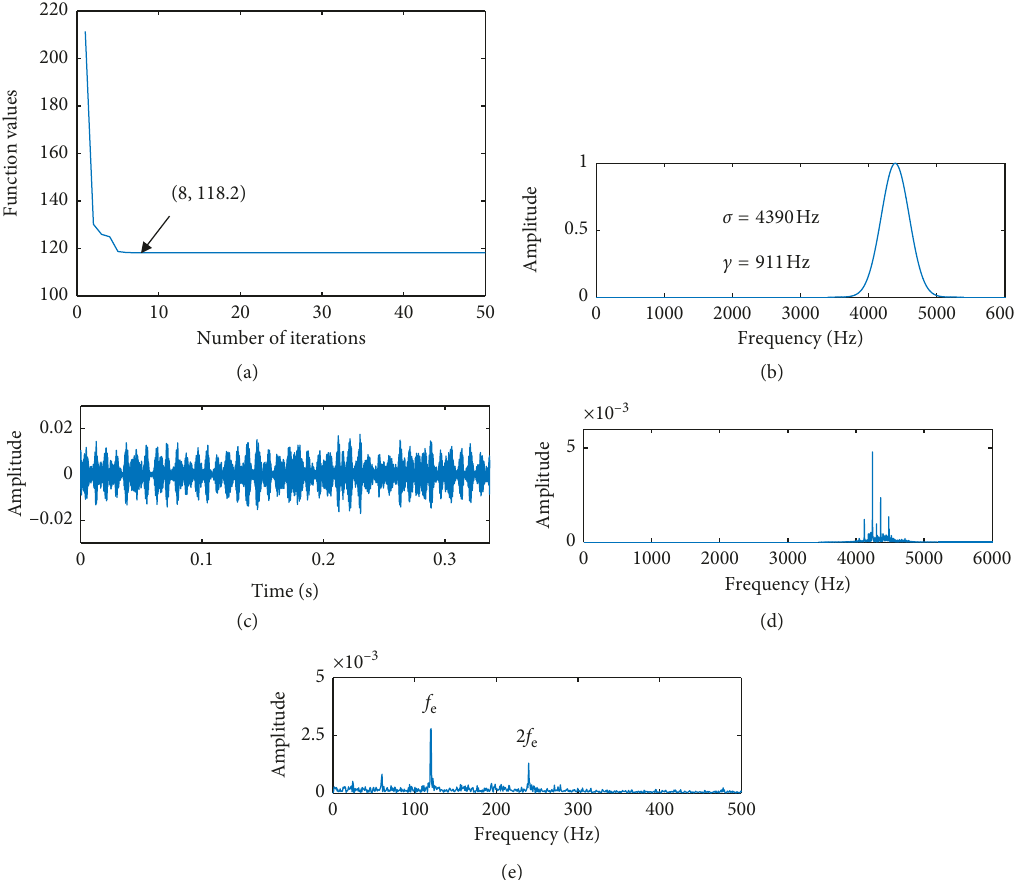
Figure 11: Diagnosis results of the single fault experimental signal by the proposed approach: (a) iteration curve for determining the optimal ARLW parameters; (b) FS of the optimal ARLW for detecting the rolling element defect information; (c) TW of the filtered signal obtained by (b); (d) FS of (c); (e) ES of (d).